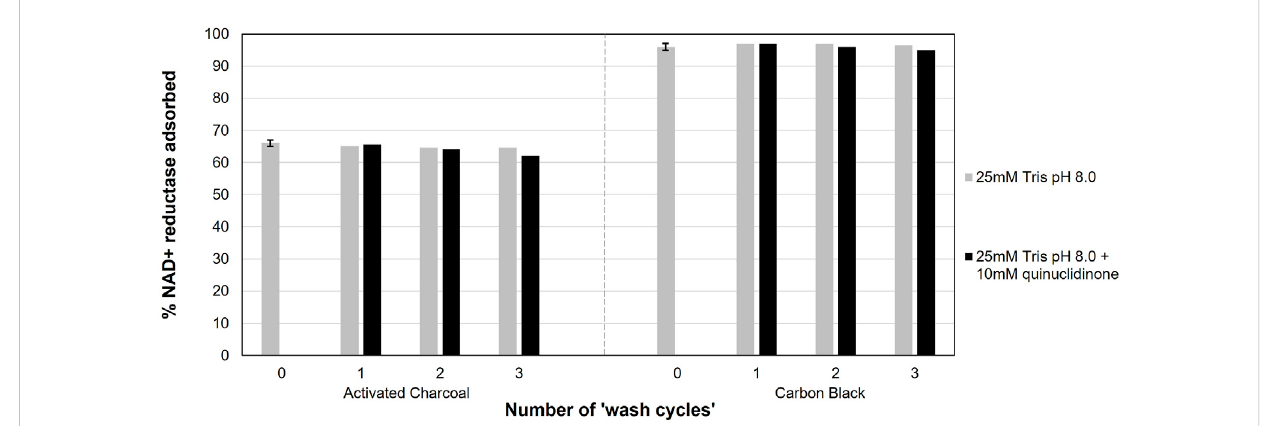
FIGURE 2 Percentage of NAD + reductase (100 µg) retained on 100 µg of carbon in the presence of Tris-HCl (grey), or Tris-HCl with 10 mM quinuclidinone (black)afterwashcycles.Thebarsthatcorrespondwith “ 0washcycles ” wereperformedinduplicate,withtherangerepresentedaserrorbars(±1%NAD + reductase adsorbed in both cases). See 2.3 for details about the immobilising and washing